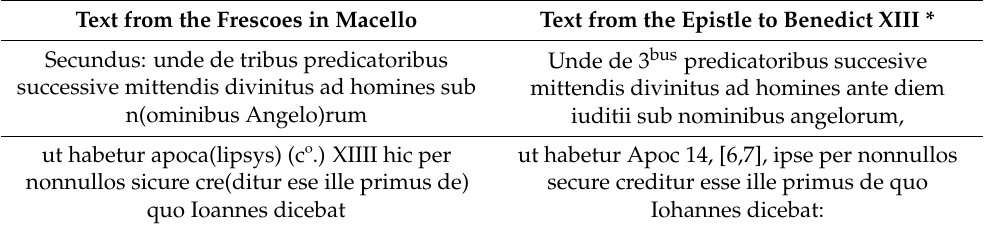
Table 3. Textual comparison, banderole 3 in the vision of beatus Vincentius. Text from the Frescoes in Macello Text from the Epistle to Benedict XIII *